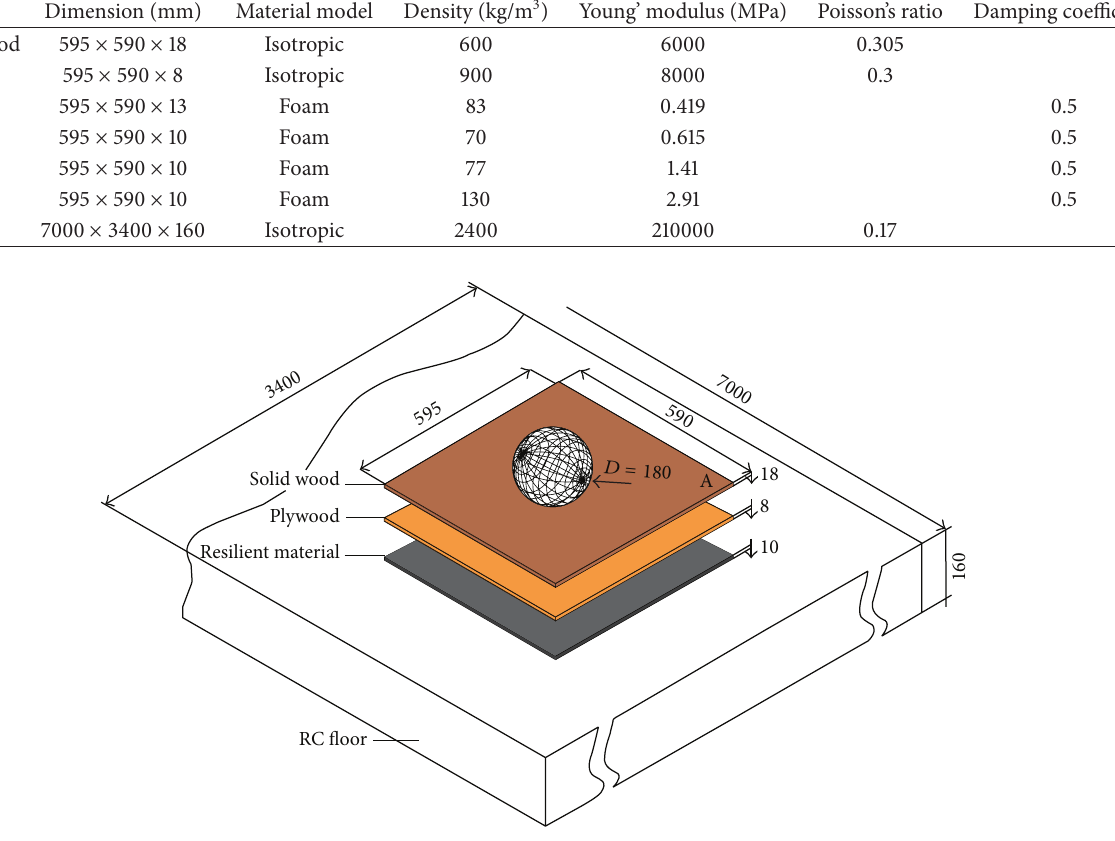
Figure 3: Schematic diagram for impact vibration measurement.